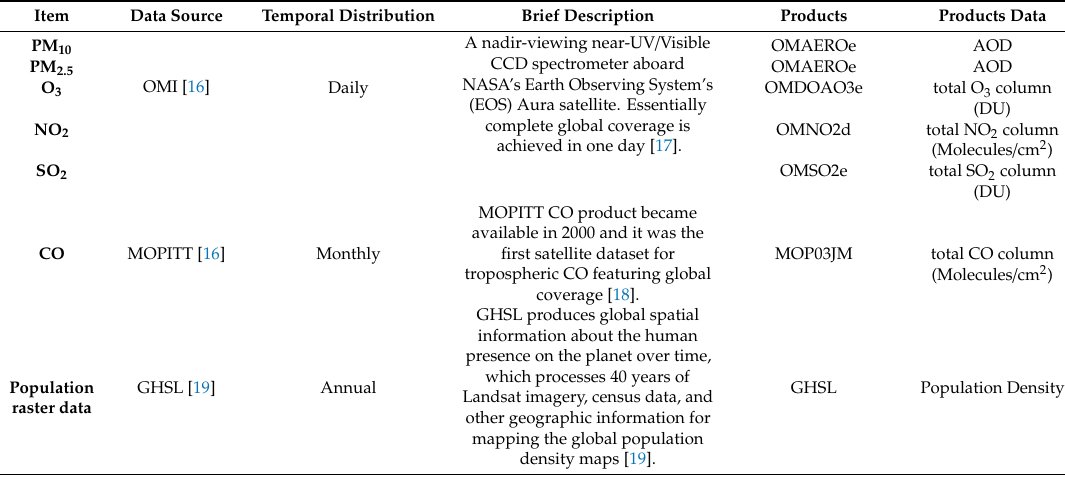
Table 1. The data source of remote sensing data applied in this study.